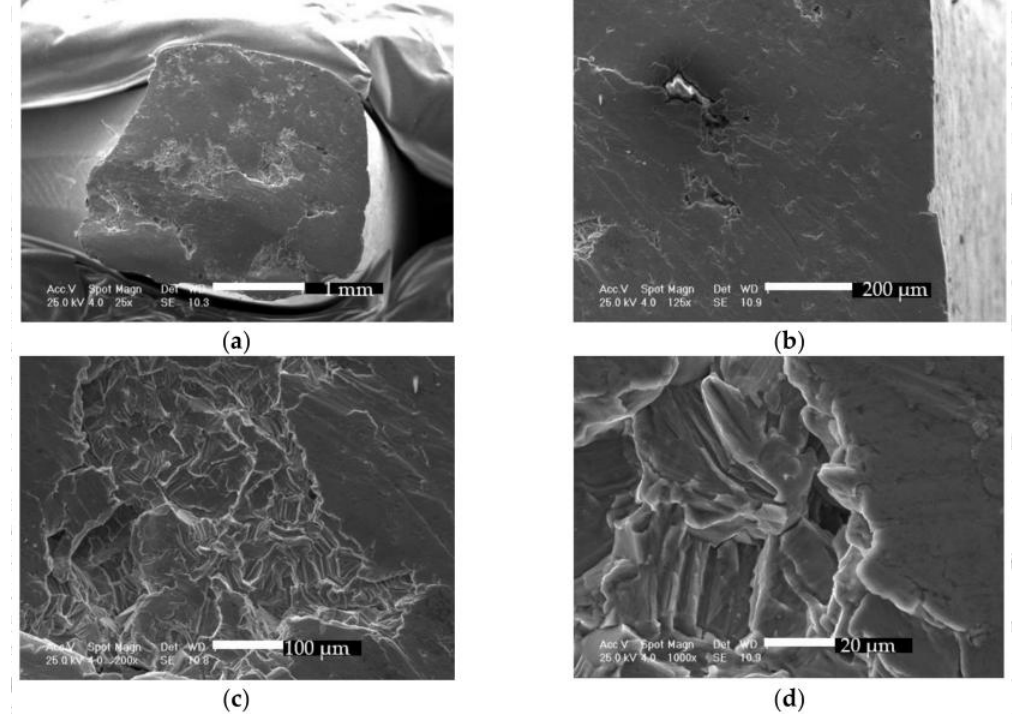
Figure 18. Scanning electron micrographs showing fracture surface morphology on first failure region: ( a ) first failed section at 25 × ; ( b ) sliding marks and lips at 125 × ; ( c ) typical brittle failure of the central region at 200 × ; ( d ) typical brittle failure of the central region at 1000 ×